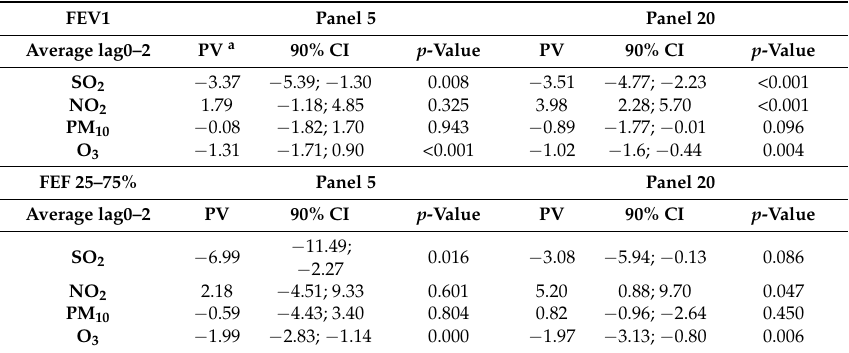
Table 4. Percent variation (PV) and 90% confidence interval (90% CI) in FEV1 and FEF 25–75% for each 10 µ g/m 3 increase in pollutant concentration. Sarroch (Sardinia), Italy (January–June 2007).